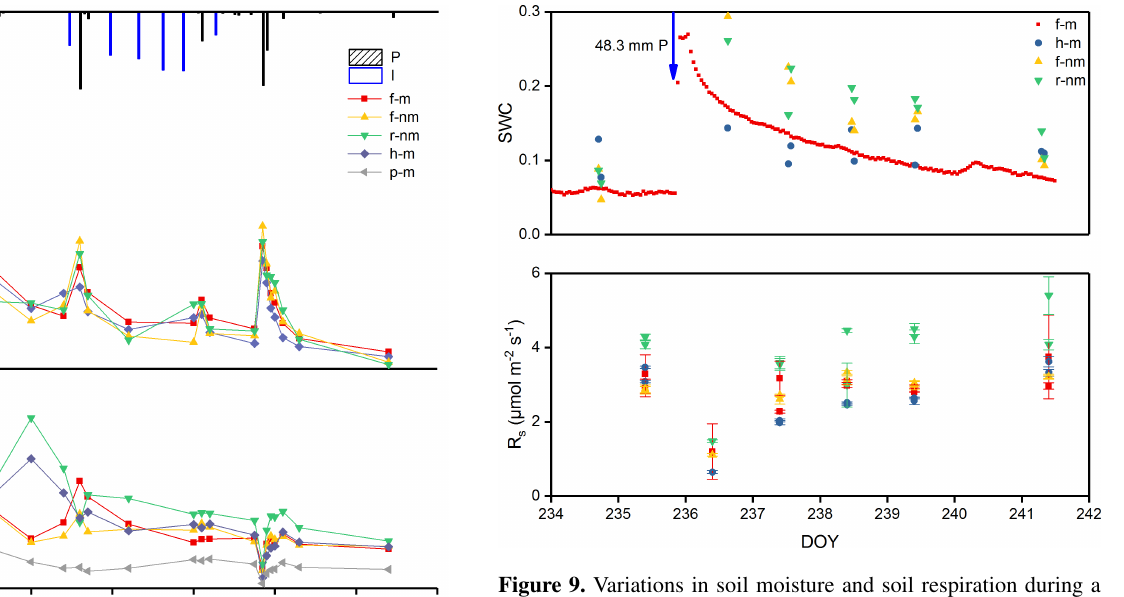
Figure 9. Variations in soil moisture and soil respiration during a wetting–drying cycle after a heavy